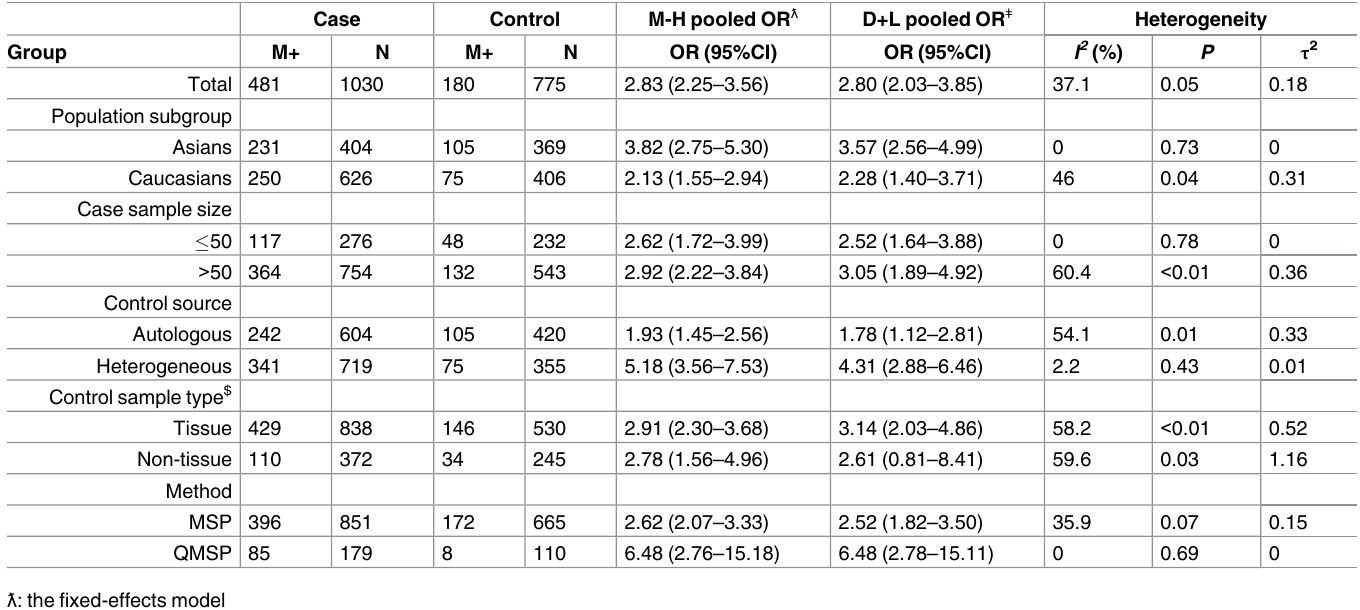
Table 3. Summary of the subgroup